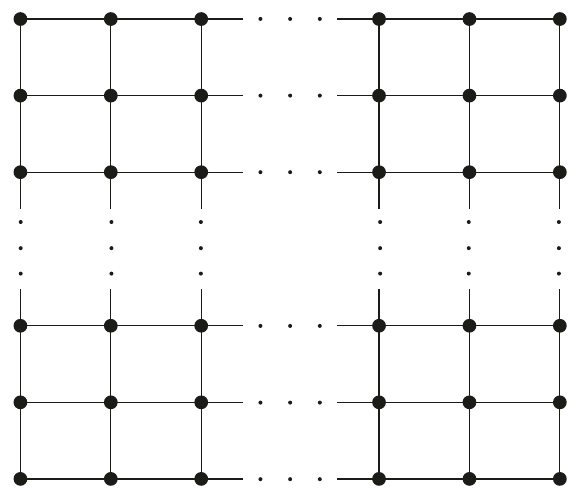
Figure 4: Square lattice graph, SL